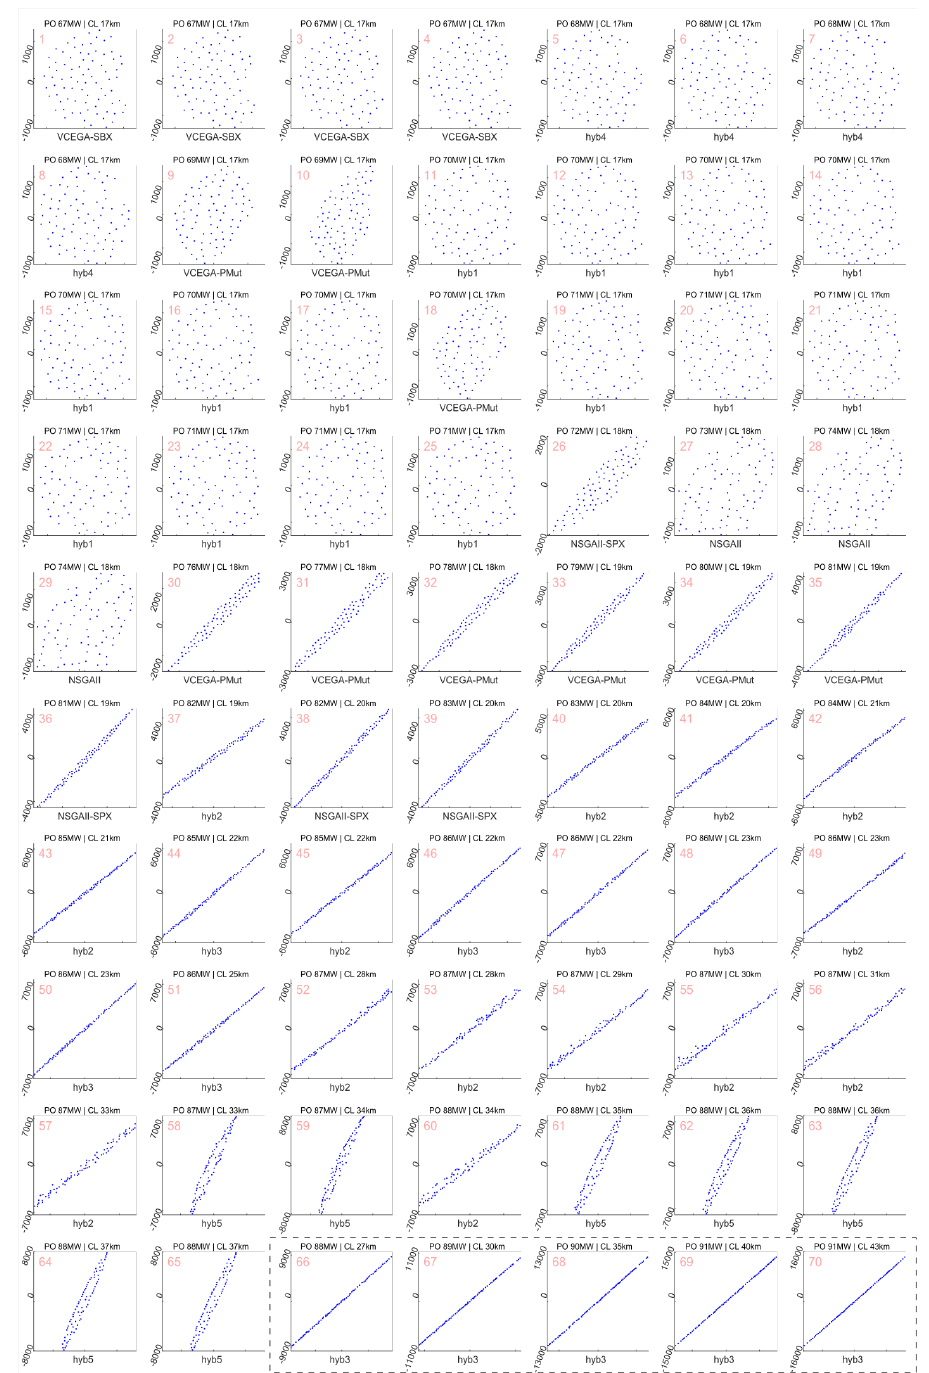
Figure 8. Set of obtained solutions (wind farm layouts) throughout the obtained aggregated Pareto front in the final generation. Top labels at each solution show the PO and CL values obtained, while bottom labels indicate the algorithm producing it. Solutions are sorted from minimum CL (top left) to maximum PO (down right), following the aggregated Pareto front (black line at Figure 7). The dashed square marks out a selection of the solutions exclusively obtained with no maximum WF length